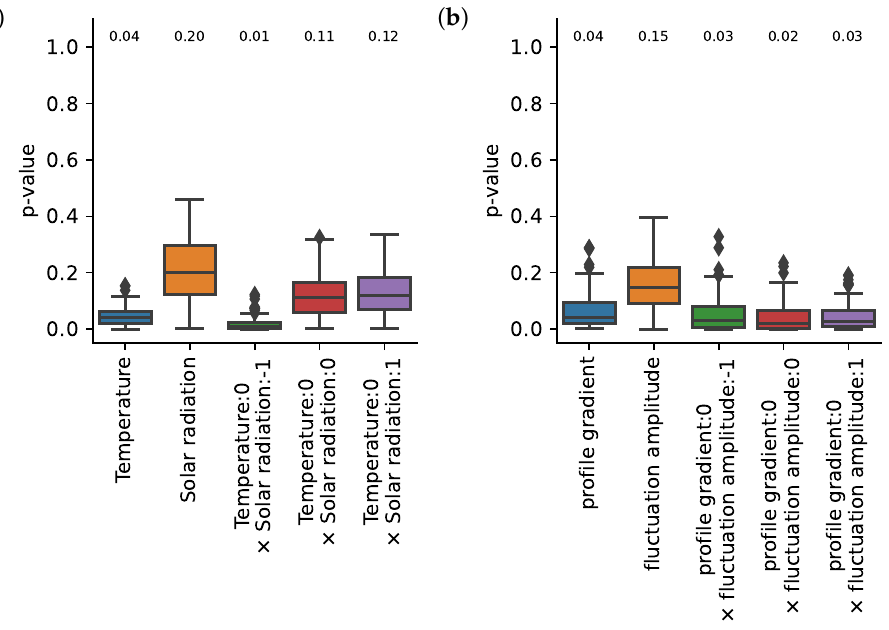
Figure 6. Markov property of two real systems. ( a ) Weather data: daily mean temperature and solar irradiation at the same location for 23 years; ( b ) nuclear fusion data: profile gradient and fluctuation amplitude of plasma in a